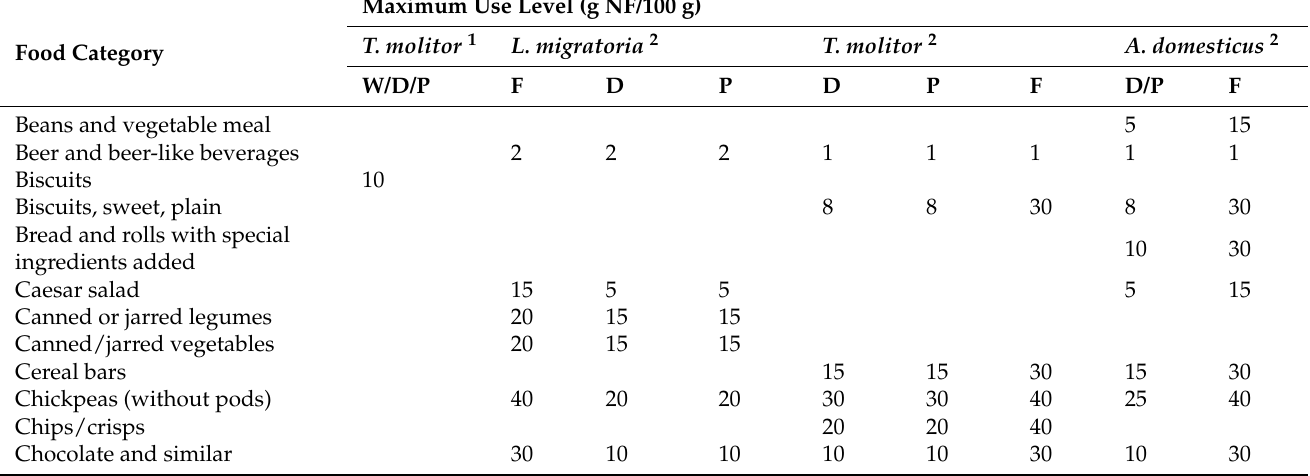
Table 1. Food products and the maximum use levels reported in the four EFSA opinions on insects as novel foods